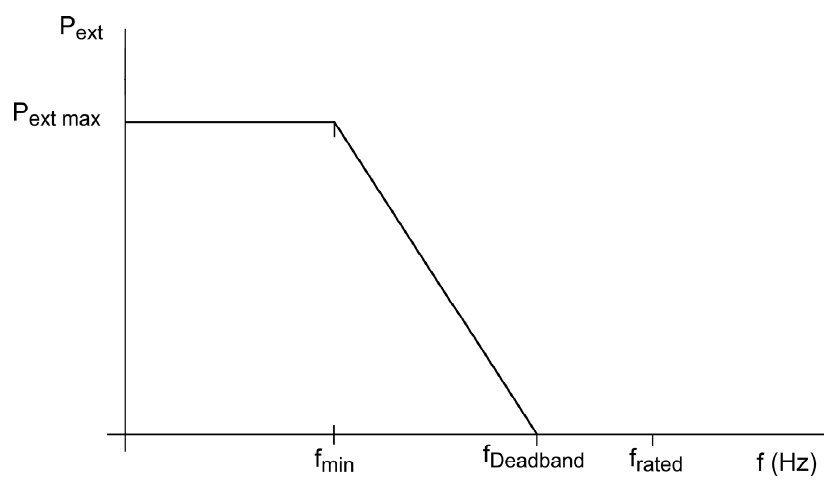
Figure 8. Graph behavior of the inertia emulation considered.